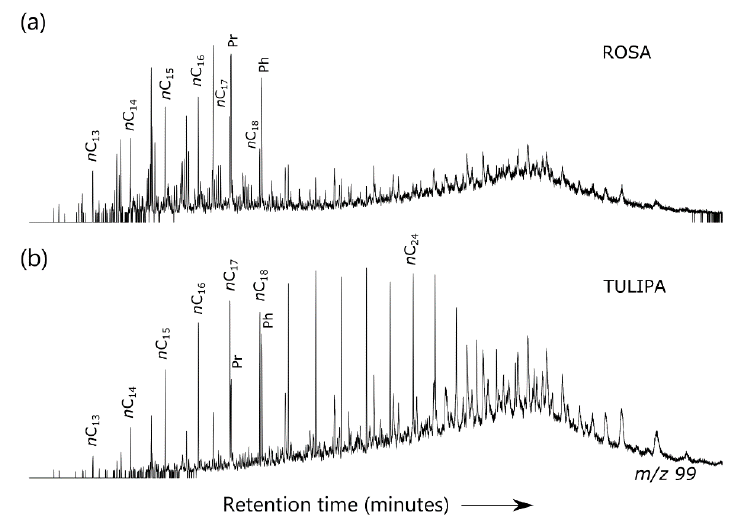
Figure 3. ( a ) and ( b ), respectively, m/z 99 ion chromatograms showing saturated hydrocarbon signals for typical oils from the lower and upper Malembo reservoirs.